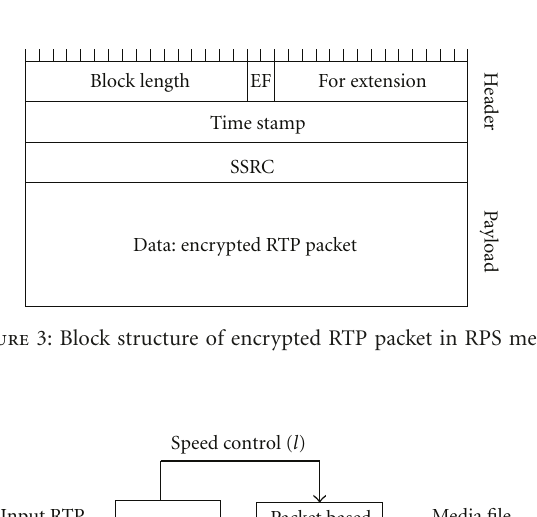
Figure 2: Architecture and control process of AdmireRPS.